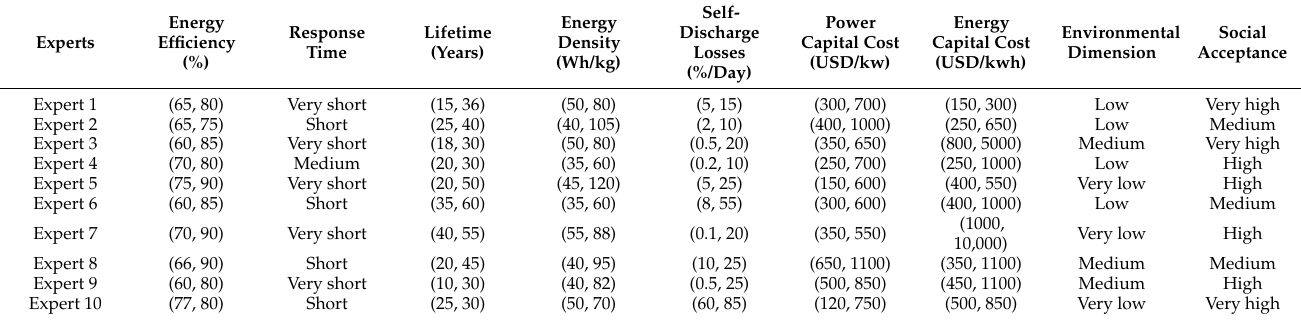
Table A22. The expert’s evaluation information in Scenario